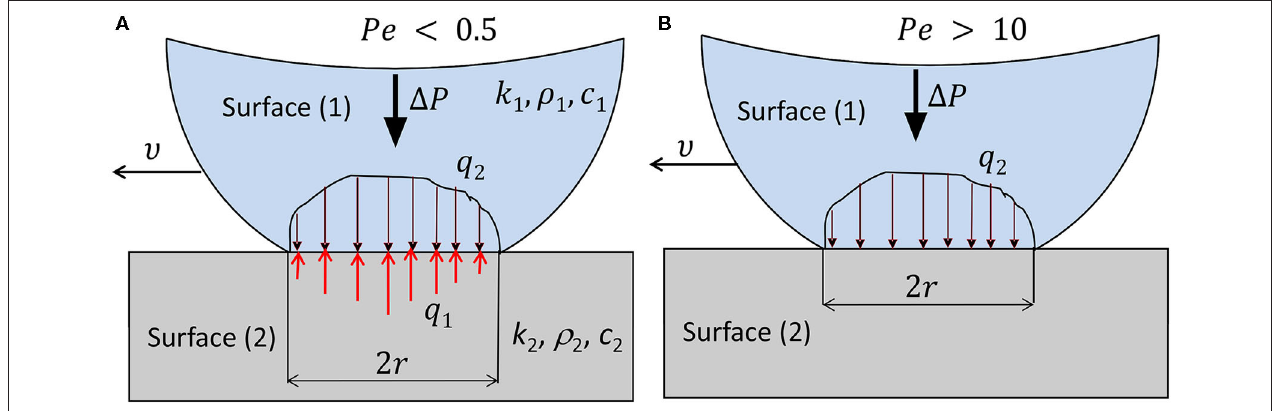
FIGURE 7 | A model of heat conduction at the asperity microcontact level for (A) slow and (B) fast sliding contact